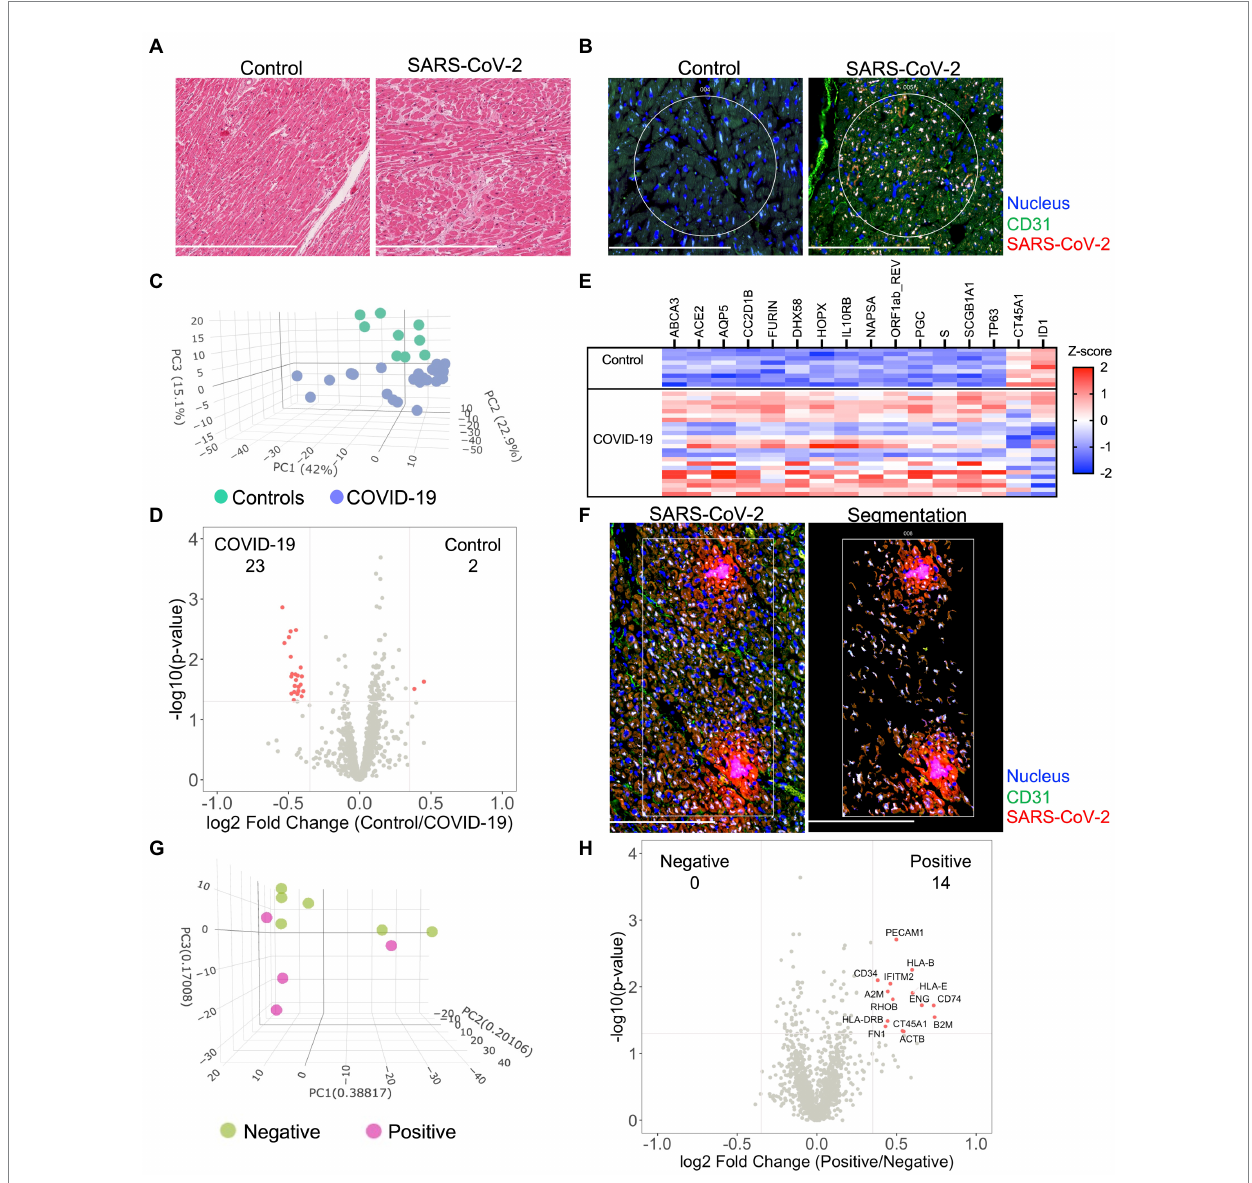
FIGURE 1 Severe acute respiratory syndrome coronavirus-2 (SARS-CoV-2) infects the myocardium and promotes differential expression patterns in patients with severe COVID-19. Histological analysis of the myocardium stained by H&E (A) or by immunofluorescence for SARS-CoV-2 nucleocapsid and CD31 expression (B) . Circles highlight representative ROIs. Heterogeneous expression of SARS-CoV-2 was noted among COVID-19 samples. Initially, global transcriptional changes (independent of ROIs) were examined in myocardial tissue by combining all myocardial ROI results based upon COVID-19 status. 1,454 Genes were above the limit of quantification. Compared to controls, PCA of unsupervised data revealed pattern clustering and differential expression within COVID-19 patients (C) , data presented per ROI. Gene-expression analysis (D) , observed 25 differentially expressed genes from myocardial tissues (differential expression was defined as p = 0.02 and log2 fold change of 0.4). A gene heatmap (E) , illustrates the greatest differentially expressed genes. Following global analysis, marker-defined ROIs were segmented by SARS-CoV-2 nucleocapsid expression for gene-expression analysis (F) , representative image for “positive” ROI. Among COVID-19 patients, PCA of SARS-CoV-2 positive tissue revealed pattern clustering (G) , enrichment of endothelial cell markers, and upregulation of key inflammatory genes (H) . COVID-19 ( n = 8 patients, 25 ROIs) and control ( n = 4 patients, nine ROIs). Scale bars are 250 μ m for each